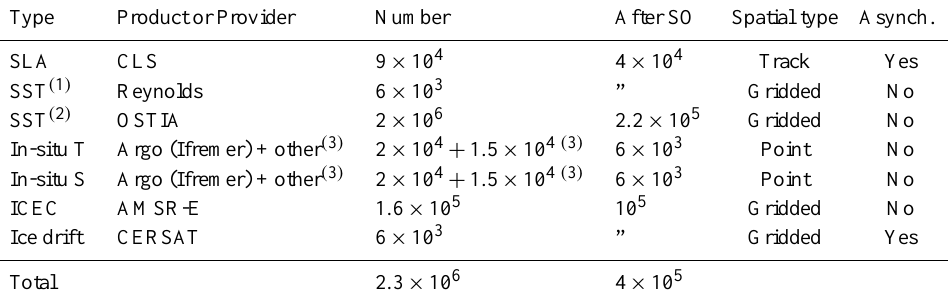
Table 1. Overview of observations used in the reanalysis. Notes: ( 1 ) before 1 April 2006; ( 2 ) after 1 April 2006; ( 3 ) after 18 April 2007. Type Product or Provider Number After SO Spatial type